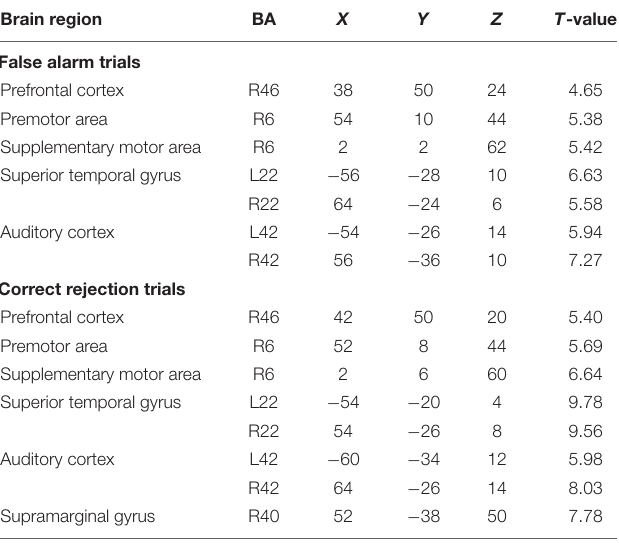
TABLE 1 | Brain regions activated during false alarm and correct rejection trials.